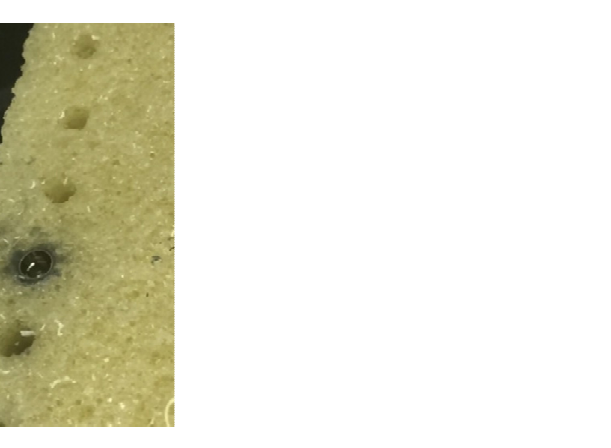
Figure 1. Metal particle apposition in bone block in vitro immediately after surgery.